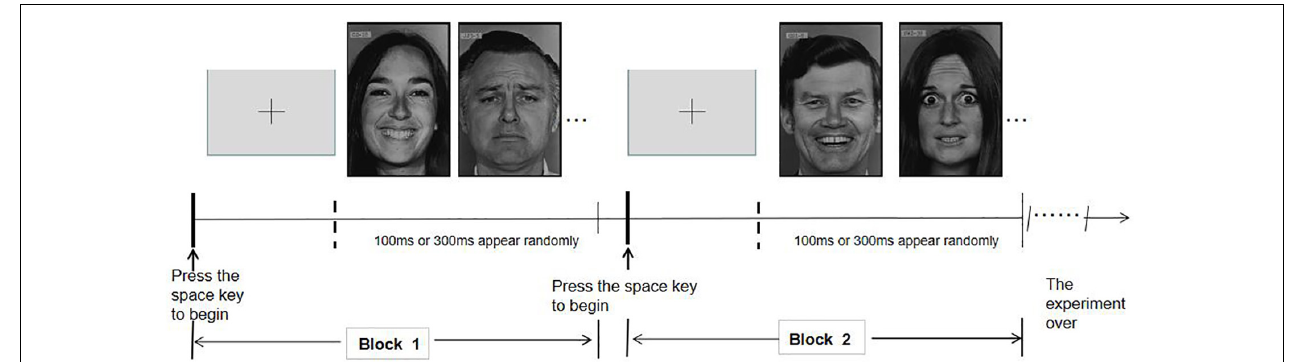
FIGURE 1 | Graph of emotion recognition